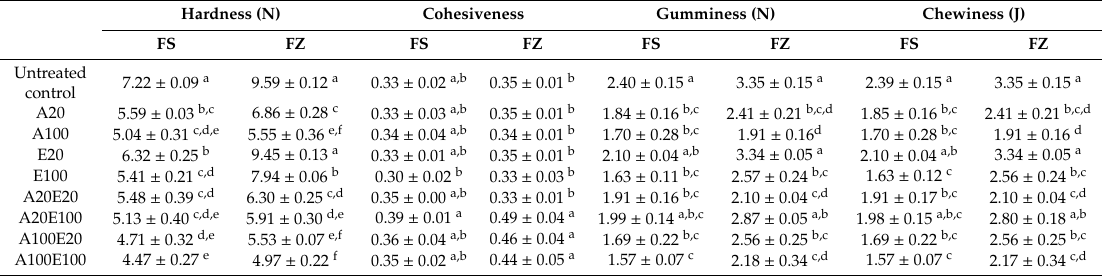
Table 2. Texture profile analysis results of enzyme-treated fresh and frozen bread doughs stored for 5 days † .